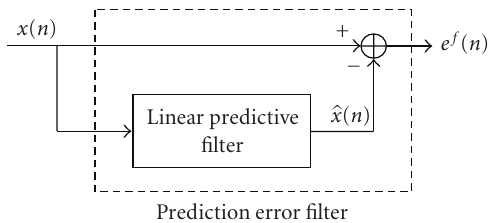
Figure 2.1 . The implementation of the linear predictor as a whitening filter of an input AR process.